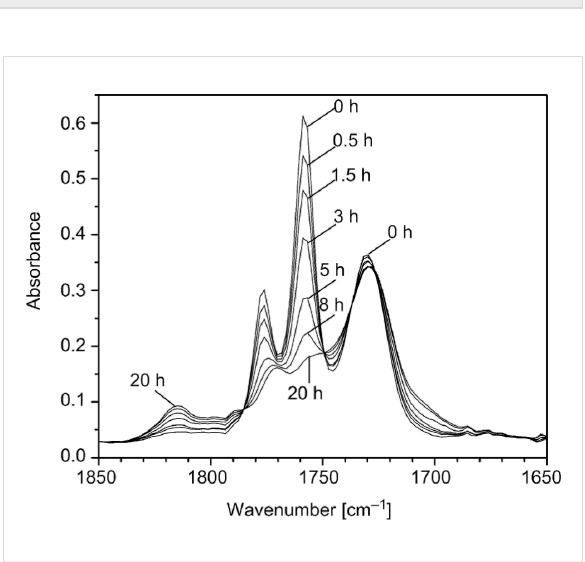
Figure 1: FTIR spectra of MCQ/S film after irradiation in a carousel for the indicated periods. Spectrum of PS film was subtracted.